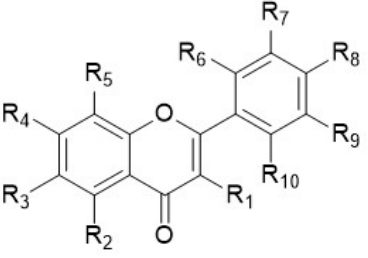
Figure 2. Chemical structure of polymethoxyflavones.